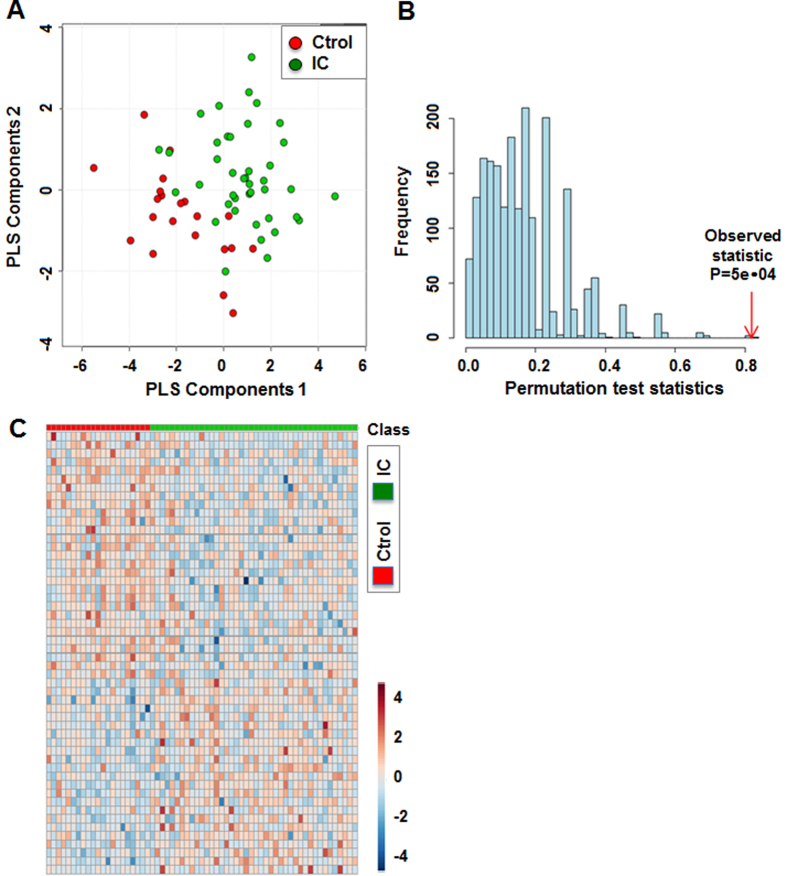
Differentiation of IC patients and healthy control groups using multivariate analysis.(A) Partial least square-discriminant analysis (PLS-DA) score plot of the IC and control groups. PLS-DA plot showed a clear separation of metabolites between patients and matched control subjects. Red: control samples; Green: IC patient samples. The model was established using three principal components. (B) For model evaluation, the class prediction results based on cross model validation predictions of the original labeling compared to the permuted data assessed using the separation distance. Histogram shows distribution of separation distance based on permutated data. Red arrow indicates observed statistic (P = 5e-04). (C) A heatmap of 52 differentially expressed metabolites in IC and control groups. Among 490 detected metabolites in total, 52 metabolites, including both annotated and unannotated metabolites, were significantly altered in IC patients compared to controls (FC > 1.20 or FC < 0.83 and P < 0.1).